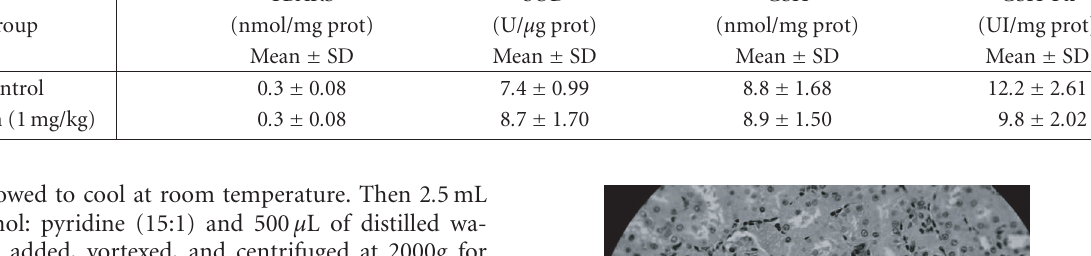
Table 2. Antioxidant status of rat kidney after chronic treatment with CDDP. Each value represents mean ± SD of eight animals. TBARS SOD GSH GSH-Px Group